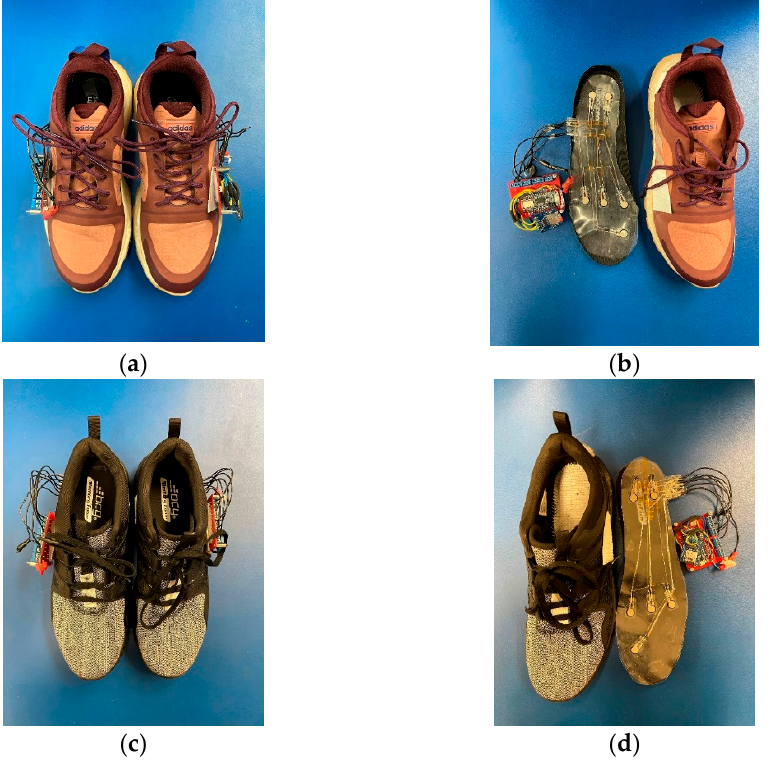
Figure 2. Ankle angle detection system: ( a ) women’s size 8.5 shoes with an integrated microcontroller and data transmission circuit; ( b ) insole with FSRs and a detection circuit for the women’s shoe; ( c ) man’s size 10.5 shoes with an integrated microcontroller and data transmission circuit; ( d ) insole with FSRs and a detection circuit for the man’s shoe.